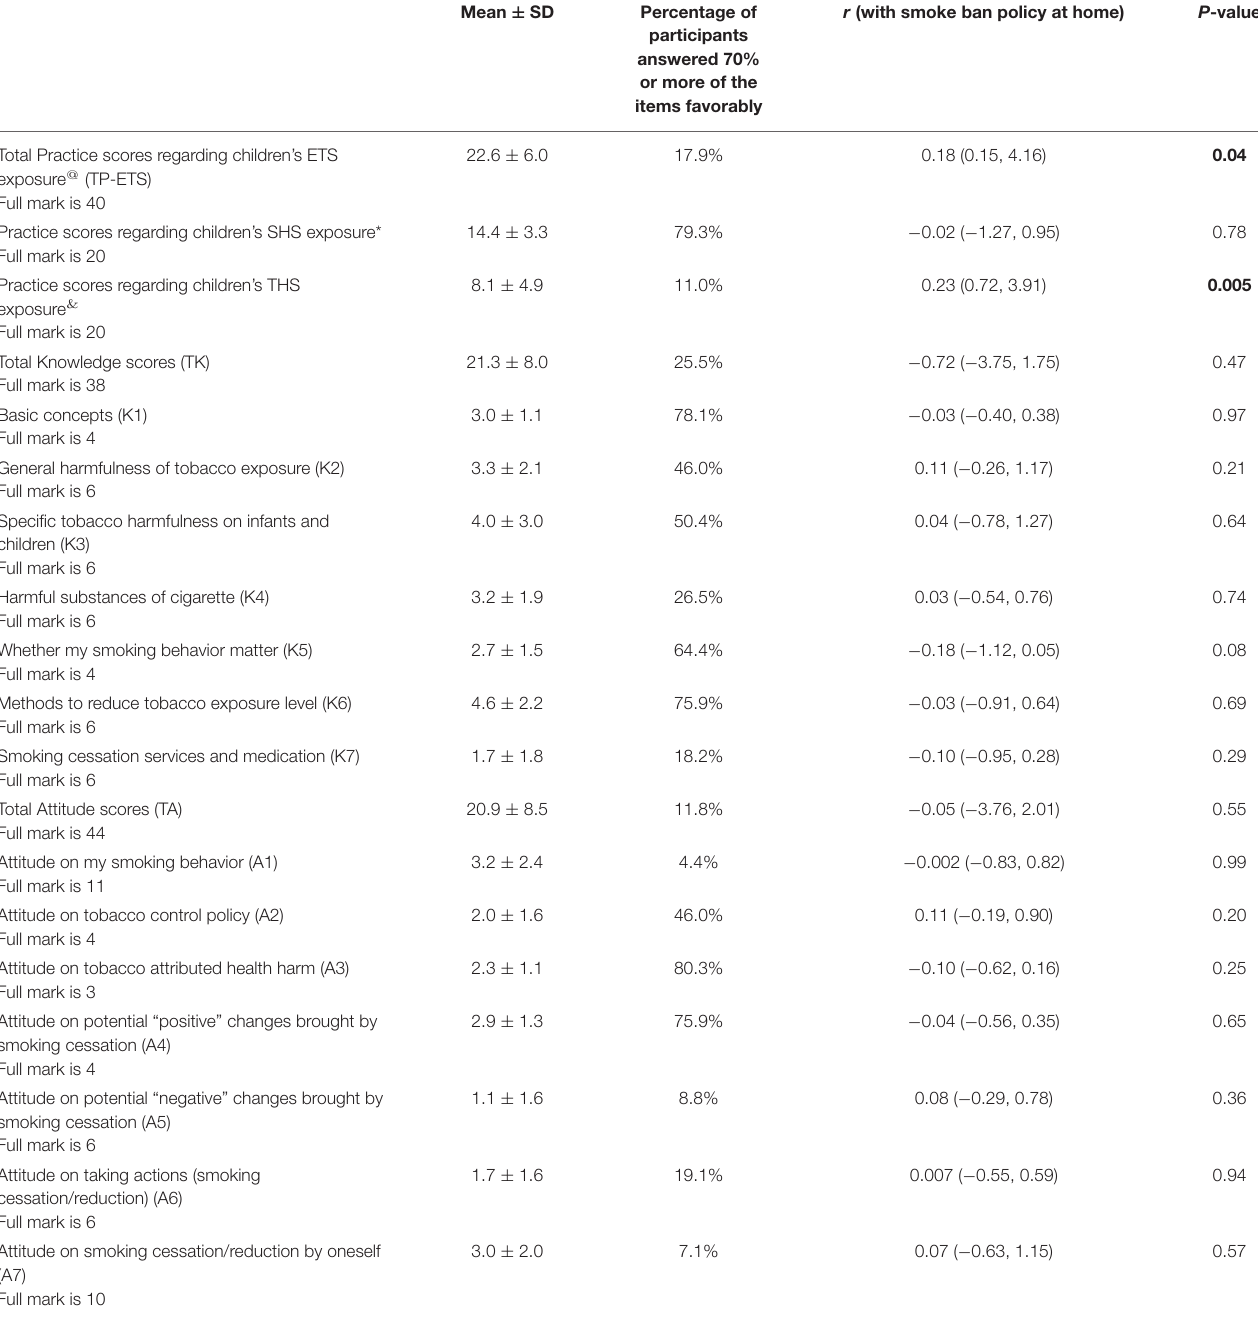
TABLE 4 | Descriptive analyses of parental KAP scores and association with smoke ban policy ( N = 145).